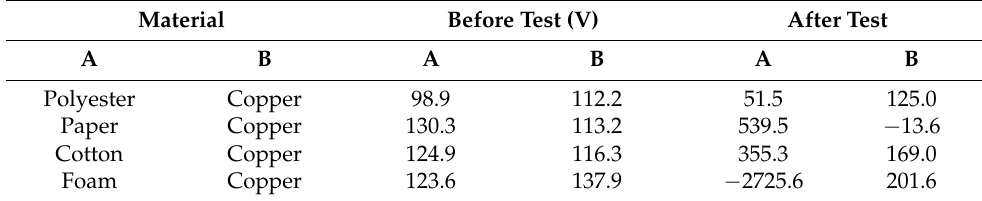
Table 1. Surface voltage caused by triboelectric charge before and after sliding five times.